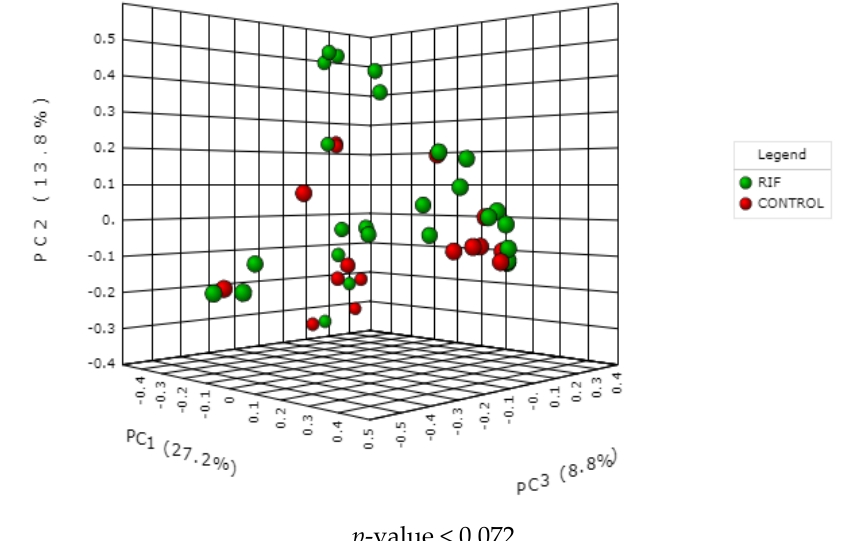
Figure 2. Beta diversity analysis. PCOA showing the clustering between the RIF (green) and control (red) groups, in which each dot represents a sample. PC1 is the principal coordinate component that generates the largest difference in the samples, with a value of 27.02%. PC2 and PC3, with a value of 13.8% and 8.8%, respectively ( p value < 0.072). MicrobiomeAnalyst MDP.